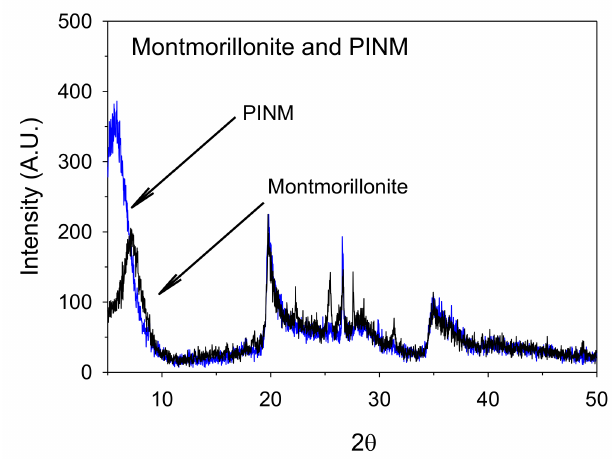
Figure 2. XRD analyses of montmorillonite and PINM.